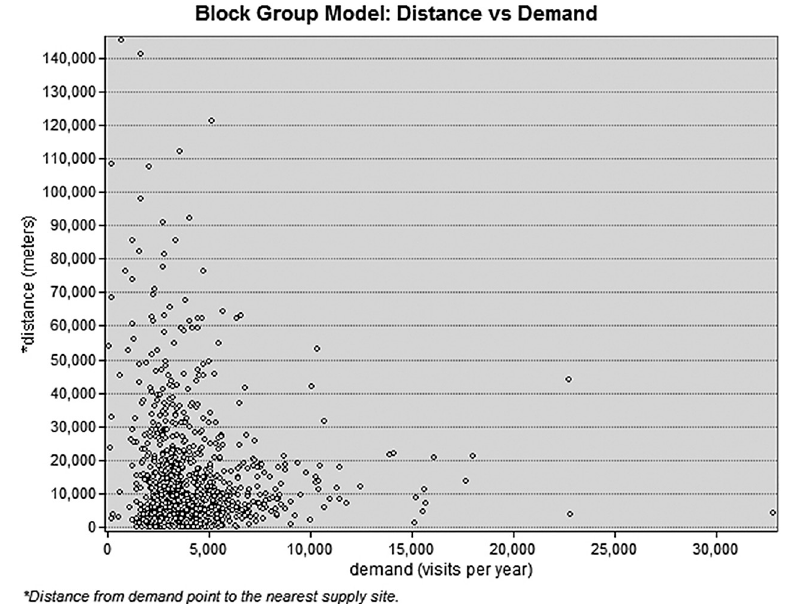
Fig. 4. Block group model: distance vs.